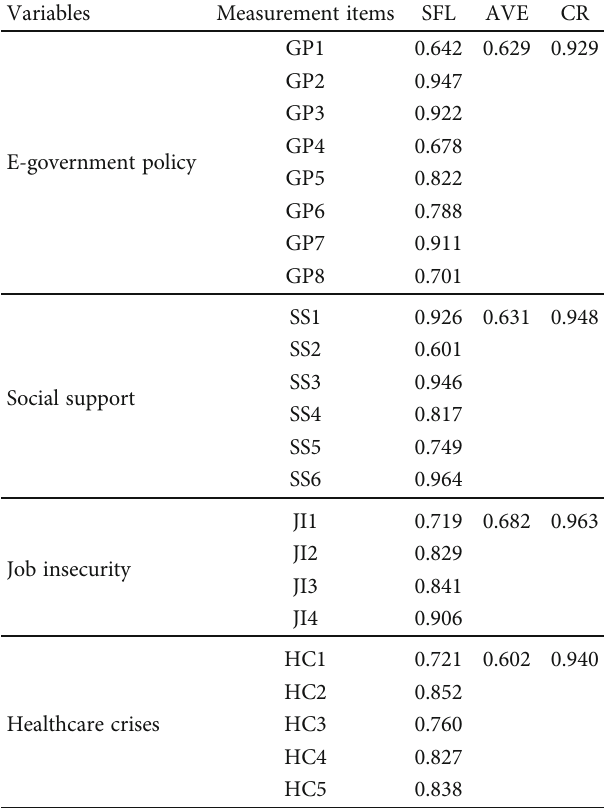
Table 1: Characteristics of survey participants.